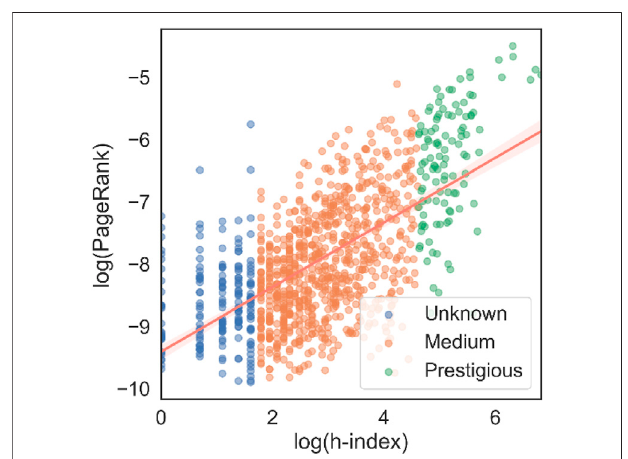
FIGURE 1 | Correlation between page rank and h-index for measuring award prestige. The colors code the groups of awards for prestigious (h-index > 100), medium, and unknown (h-index < 5). The red line shows their linear relationship, and the Pearson correlation is